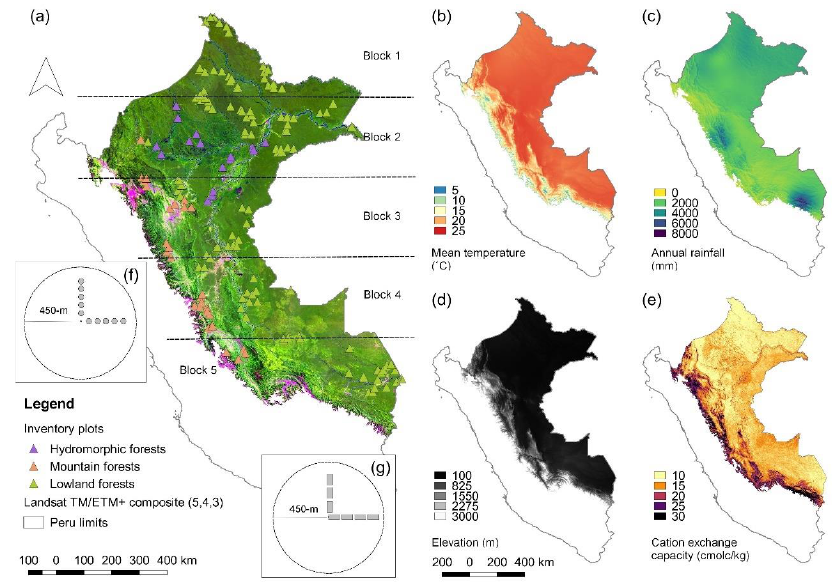
Figure 1. Geographical characteristics of the study area in Peruvian Amazonia. ( a ) Landsat TM / ETM + composite (bands 5, 4, and 3 assigned to red, green, and blue, respectively) of Peruvian